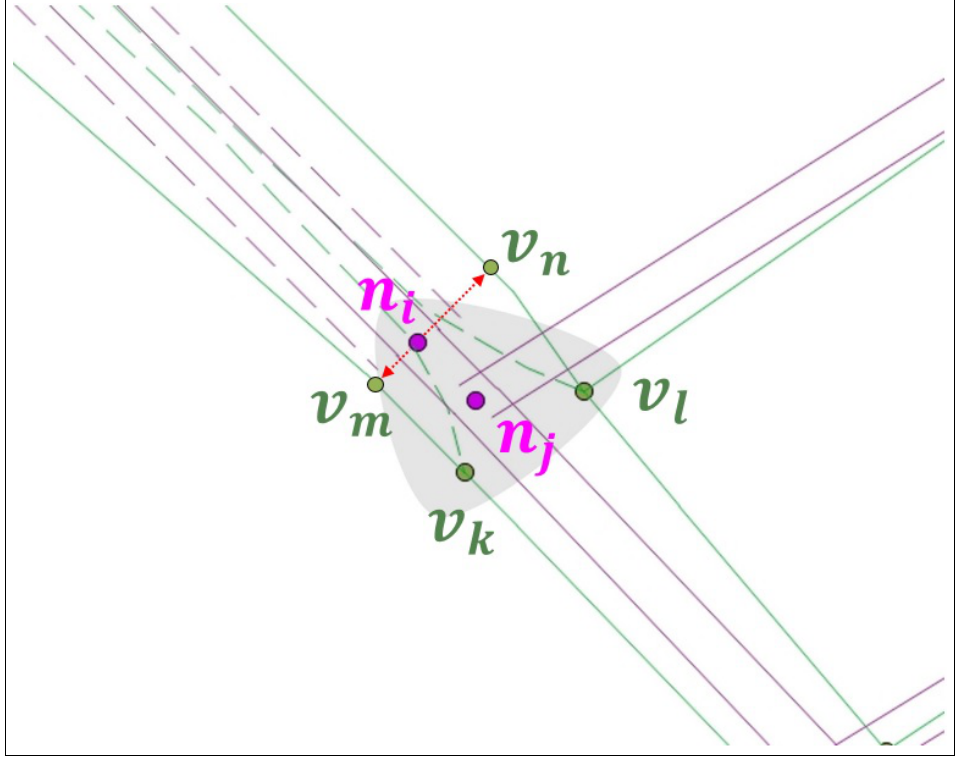
Figure 18. IM case in the